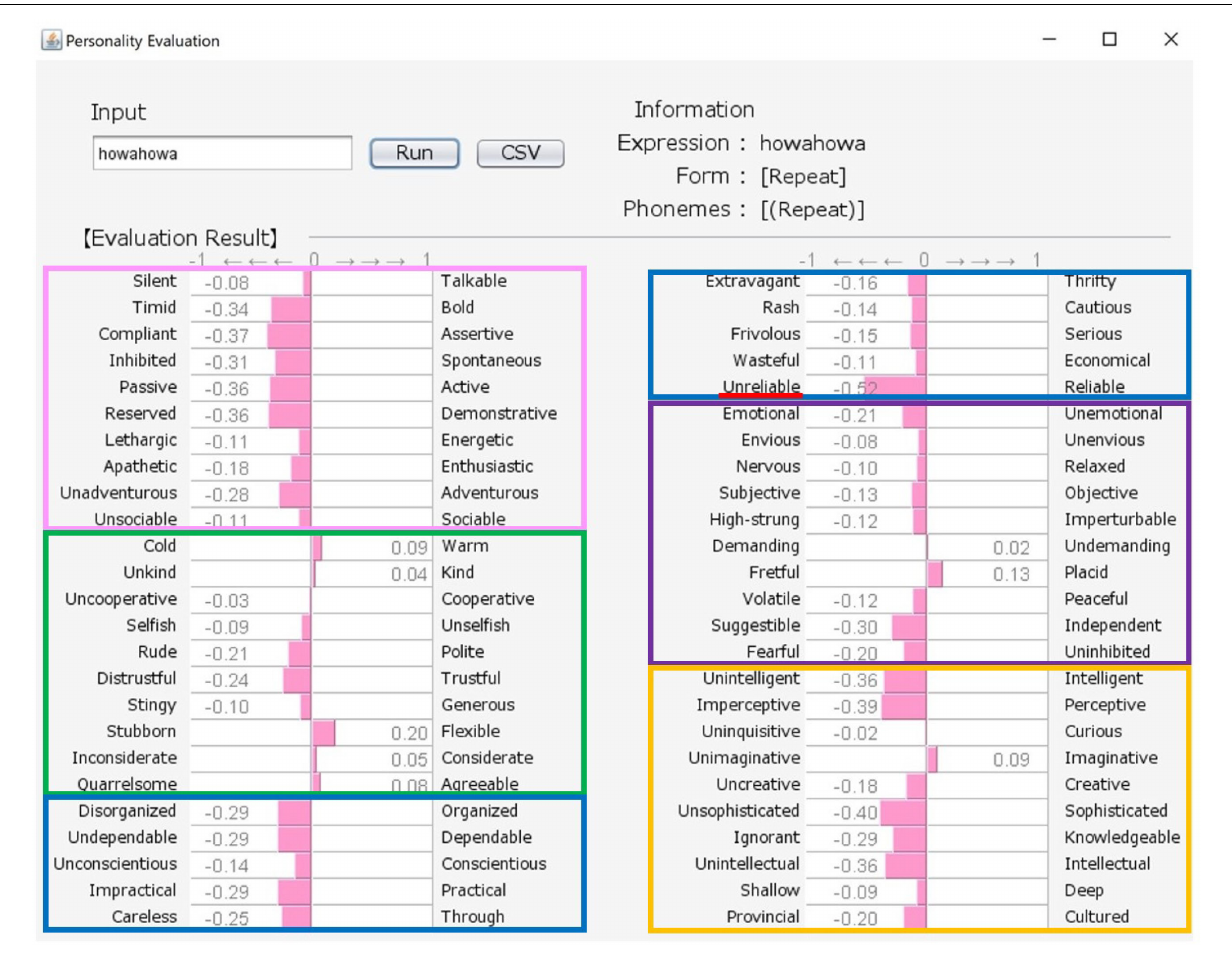
Frontiers in Psychology |